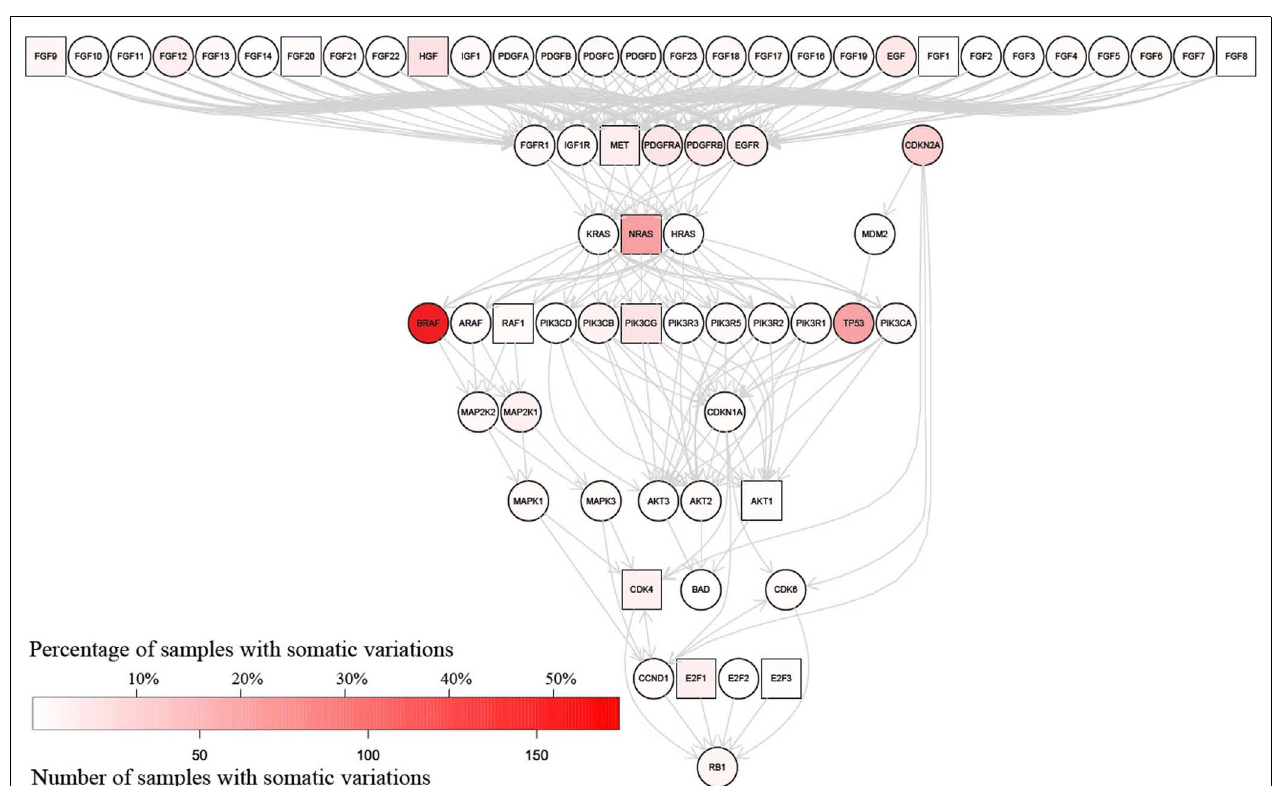
indicate RNA expression in melanoma metastases significantly associated [ p ≤ 0.05 no multiple testing correction applied, Cox proportion hazards model, Bogunovic et al. (50) data], with patient disease-free survival, while circular nodes indicate the absence of any significant association between RNA abundance and patient survival.This graph was generated using the pathwayGraph function to access the KEGG pathway information contained within the R graphite